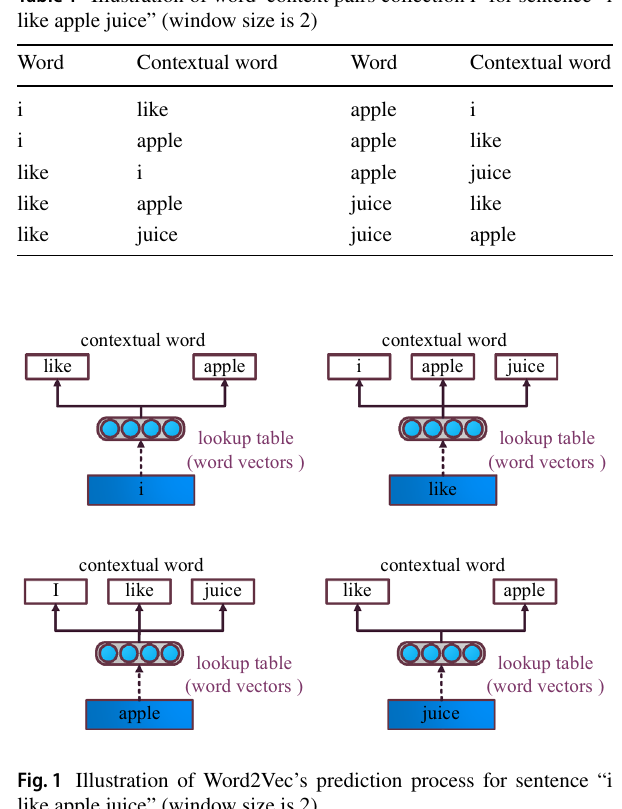
Fig. 1 Illustration of Word2Vec’s prediction process for sentence “i like apple juice” (window size is